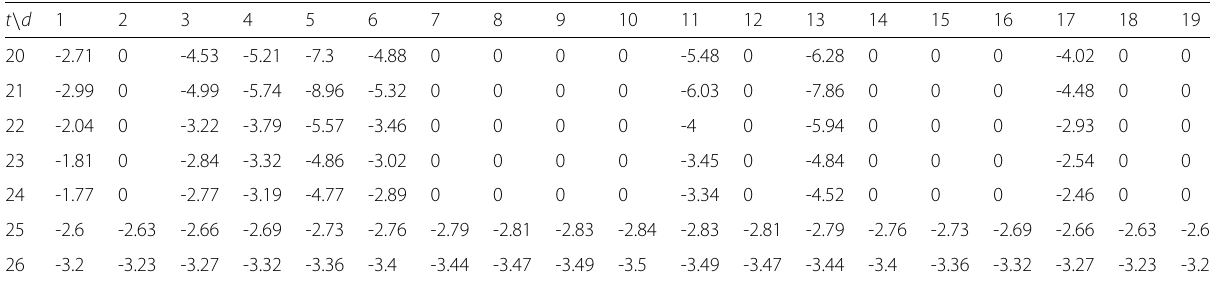
Table 13 Optimal values of